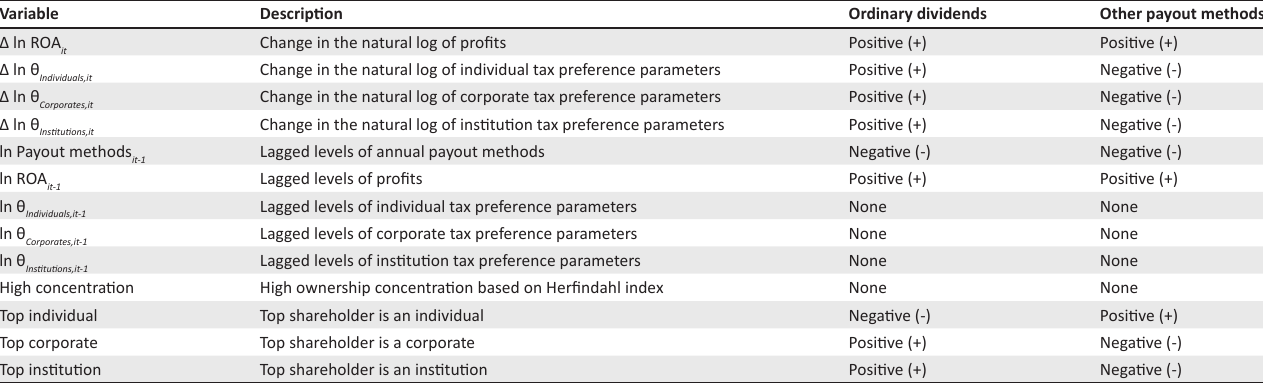
TABLE 1: Variables description and expected relationships.